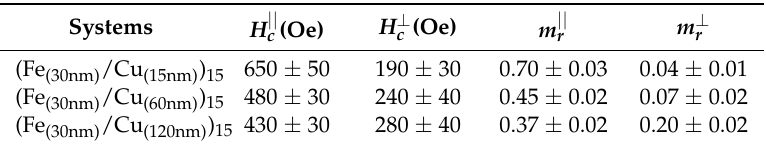
Table 1. Magnetic characteristics of the multi-segmented nanowires of (Fe (Fe length) /Cu (Cu length) ) layers: coercive field ( H c ) and reduced remanence ( m r ) measured with the magnetic field applied parallel (||) and perpendicular ( ⊥ ) to the nanowires’ long